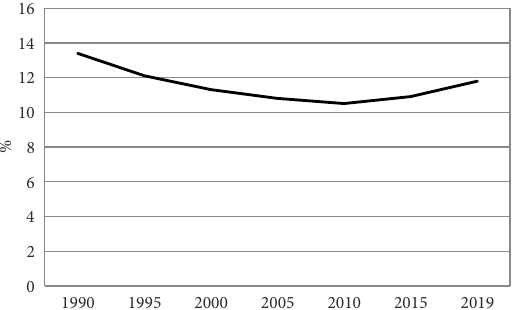
Figure 1. The dynamics of the іnternational migrant stock (%) in Ukraine (Migration Data Portal,